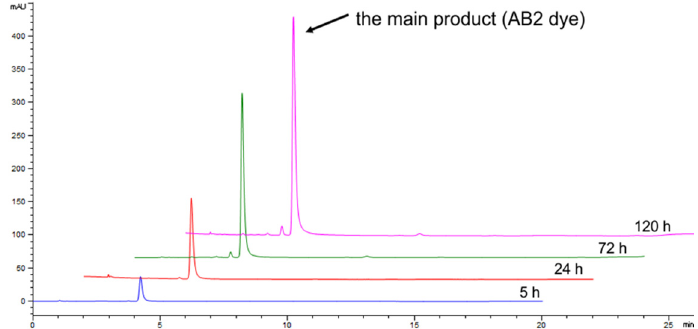
Figure 3. HPLC chromatograms of the transformation mixture detected at 500 nm containing the main product of the AB2 dye (absorption units, mAU) synthesised after 5, 24, 72, and 120 h of 5 g / L mixture of A and B2 substrates (methanol fraction).